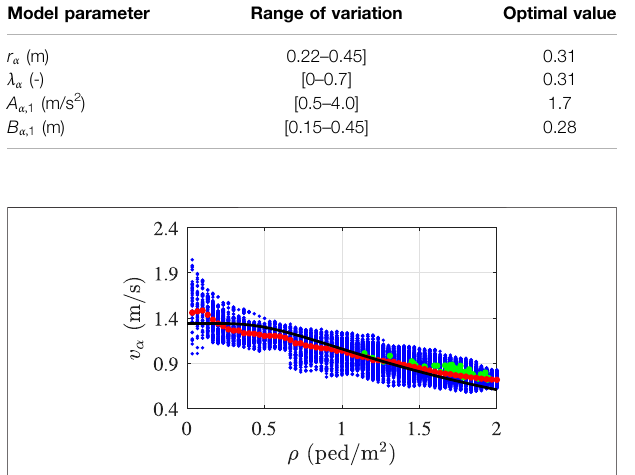
FIGURE 6 | Crowd density and velocity from criterion 1 (blue dots) and criterion 2 (green dots) and simulated speed-density relation (red dots) obtained from the calibrated model. Black curve: theoretical speed-density relation.